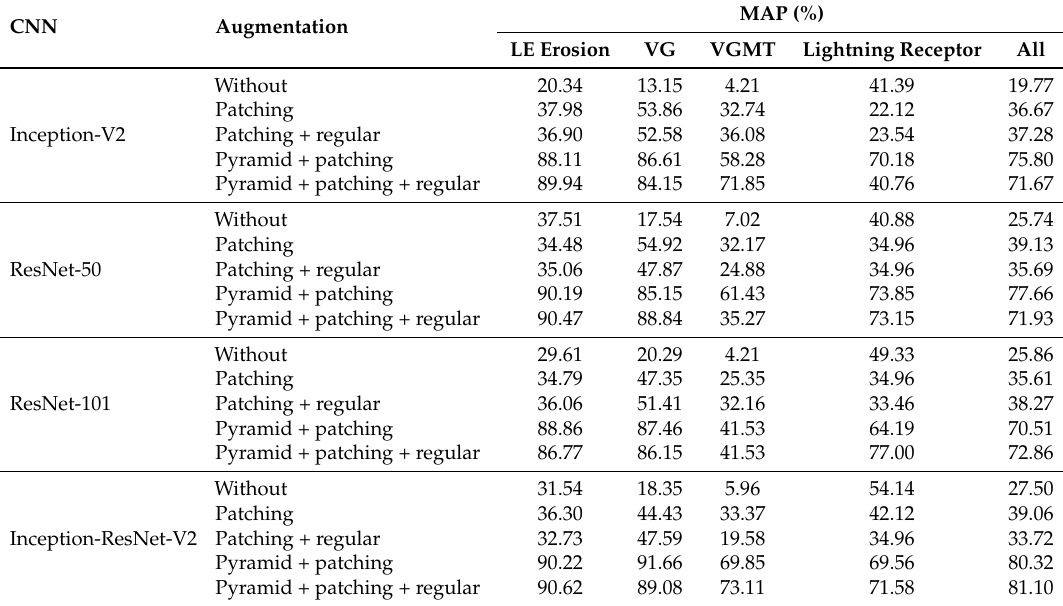
Table 2. Experimental results for different CNN architectures and data augmentation